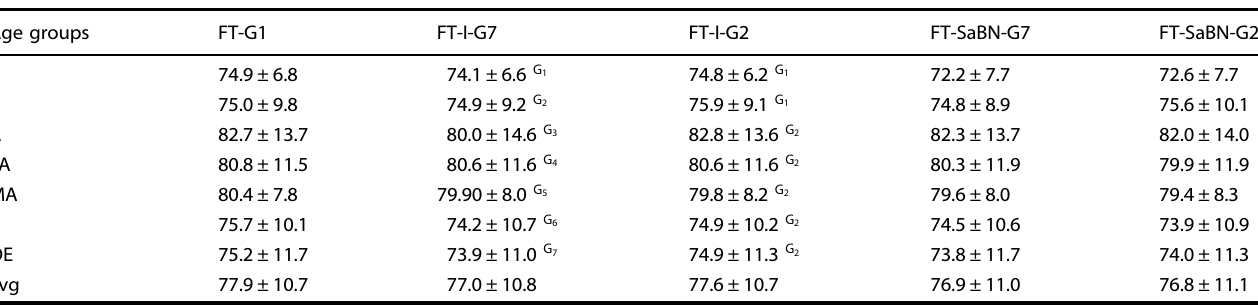
Table 4. (iii) Training conditioned by age.